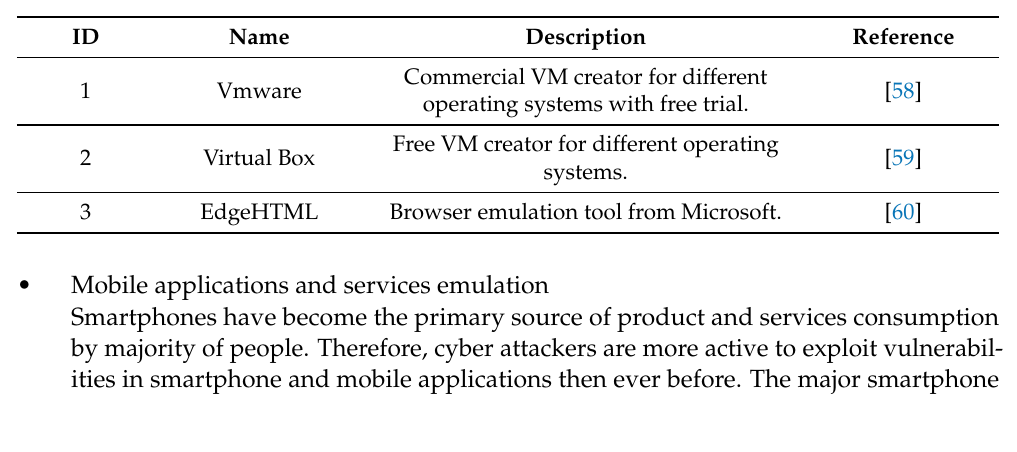
Table 12. Tools used for the creation of a virtualization